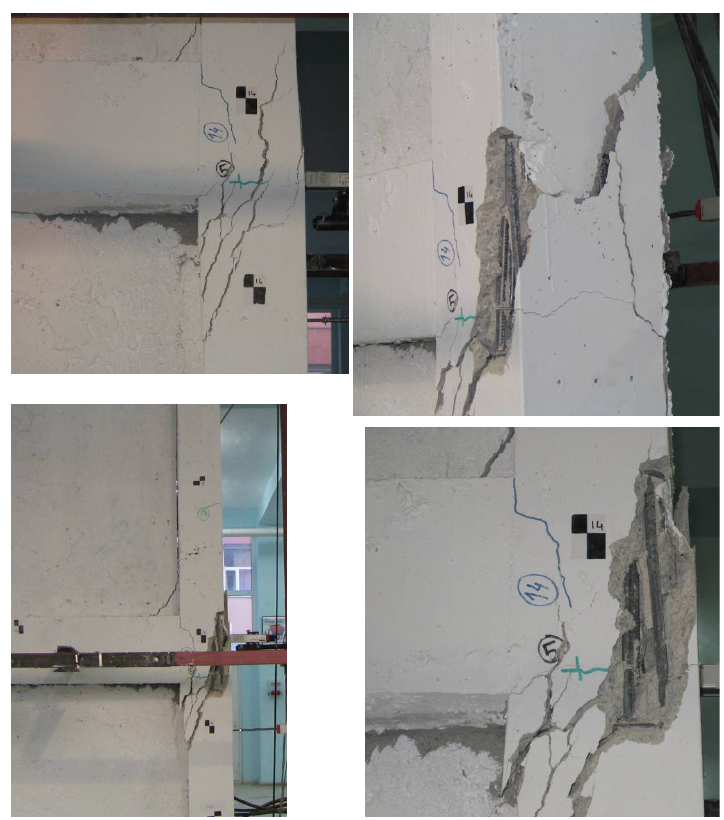
Fig. 15. Right beam-column joint failure. Figure 15 Right beam-column joint failure Table 3. Ultimate load and drift values with yield load and displacement